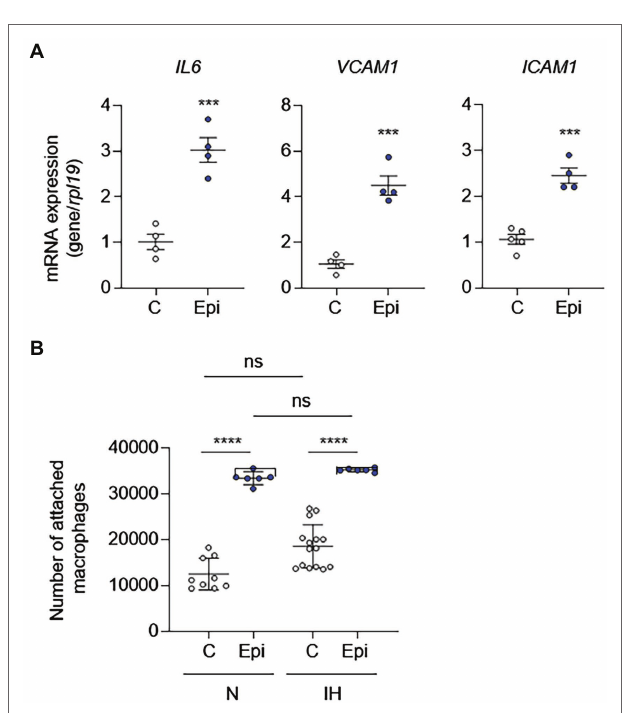
FIGURE 5 | Epinephrine alone is sufficient to induce EC activation and leukocyte adhesion in the absence of IH in vitro . We treated ECs with epinephrine (Epi; 10 μ m) or vehicle control (C) under normoxia for 24 h and then (A) assessed EC activation by measuring mRNA expression of markers of EC activation genes, including IL6 , VCAM1 , and ICAM1 ( N = 4; significance was determined by Student’s t -test) and (B) leukocyte adhesion ( N = 8–10; significance was determined by one-way ANOVA using Bonferroni’s correction for multiple comparisons). ns, not significant. *** p < 0.001; **** p < 0.0001.